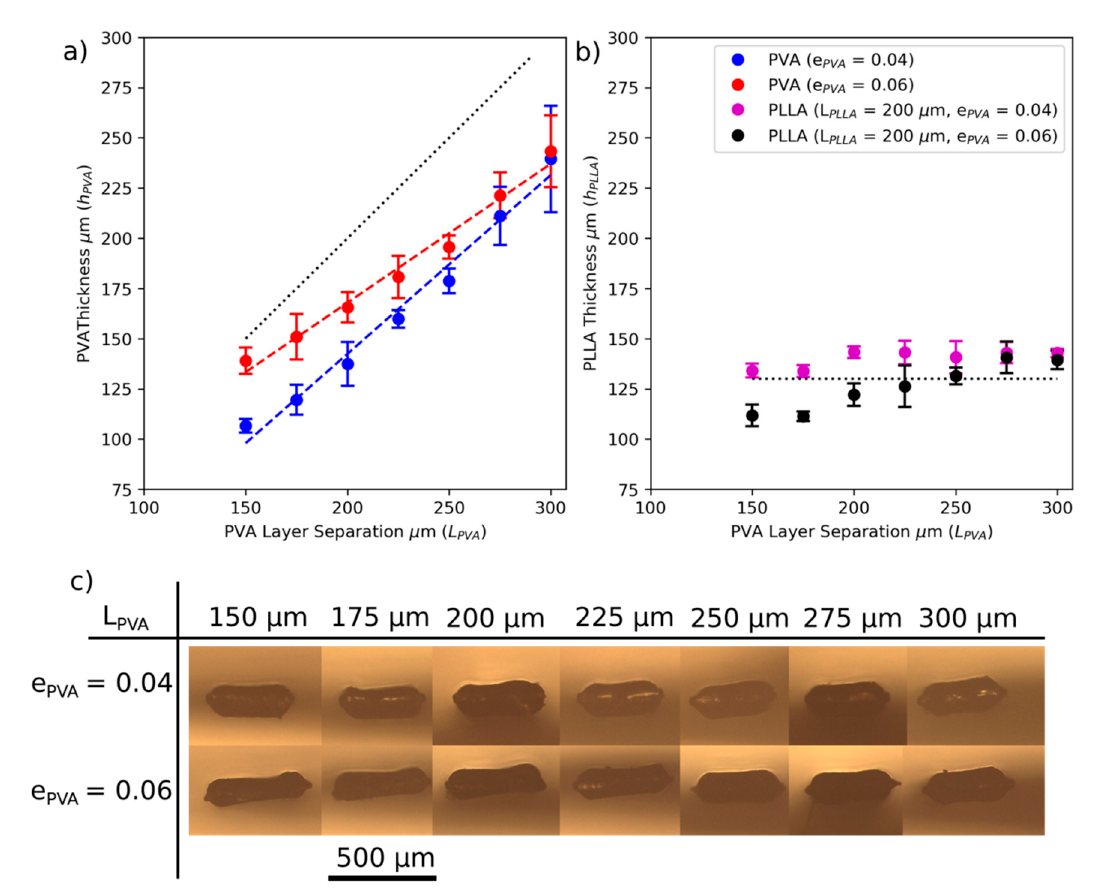
Figure 8. ( a ) The variation in measured peeled PVA thickness for layer separations ( L PVA ) between 150 and 300 µ m. Gradients of 0.89 ± 0.05 and 0.69 ± 0.04 are shown for e PVA = 0.04 and 0.06, respectively. A one-to-one variation is indicated by the black dotted line; ( b ) peeled PLLA printed at a fixed L PLLA = 200 µ m, e PLLA = 0.02 above PVA layers varying between L PVA = 150 to 300 µ m. Measured h PLLA = 130 µ m at L PLLA = 200 µ m printed directly on the printer bed is indicated by the black dotted line; ( c ) cross-sectional optical microscopy of the PLLA layers.